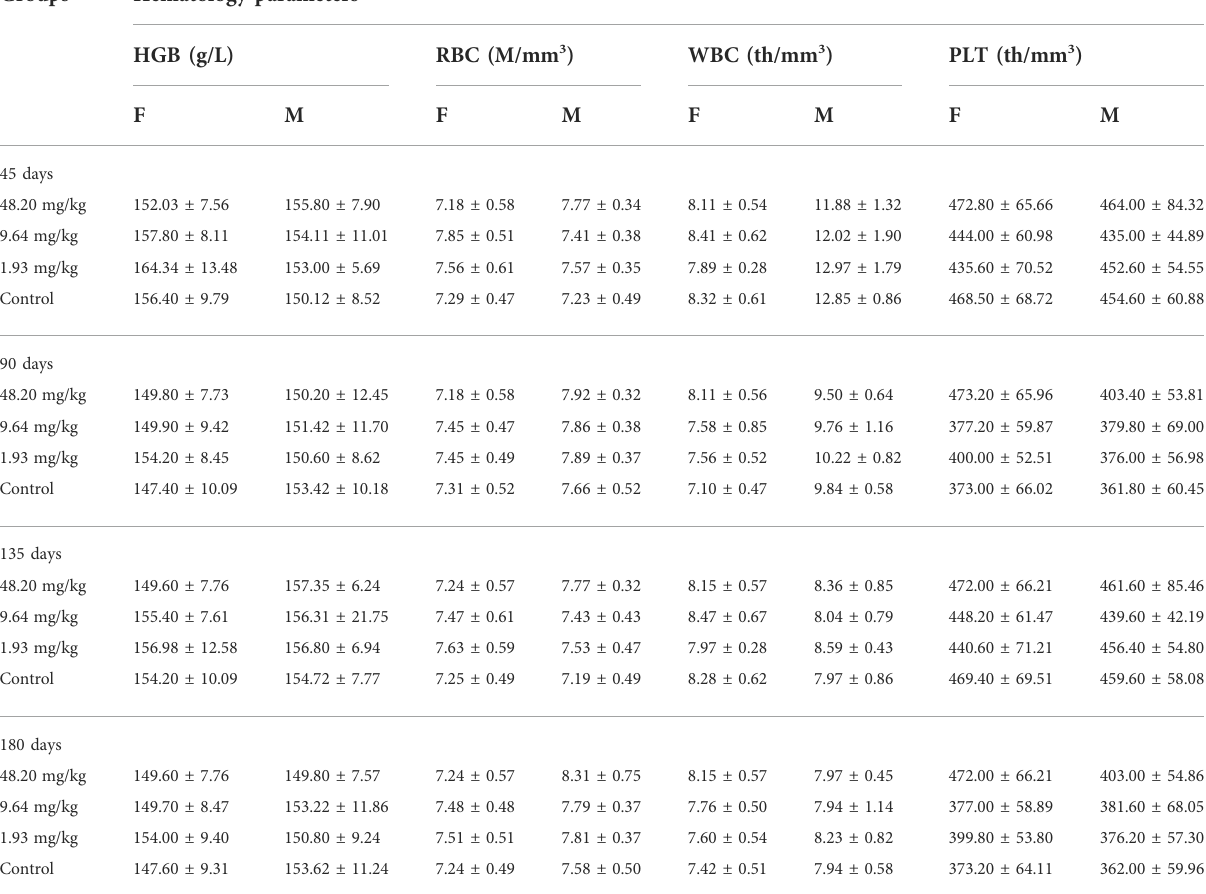
TABLE 7 Effect of MPTA on hematological parameters.